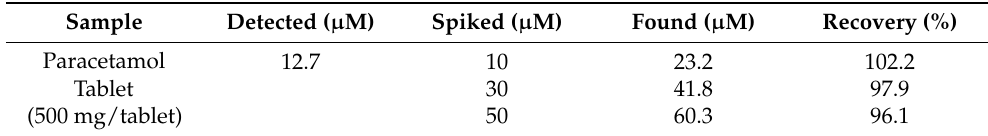
Table 2. Determination of paracetamol in pharmaceutical